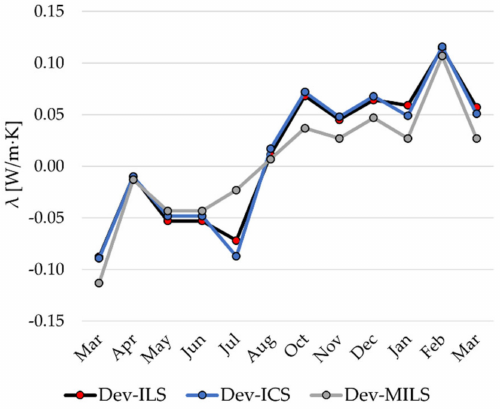
Figure 4. Deviation of the mean thermal conductivity λ for each model, with average λ at 0 W/(m · K); Dev: deviation; ILS: infinite line source; ICS: cylinder source; MILS: moving infinite line source; connecting lines do not represent collected data but are used for unambiguous visualization.